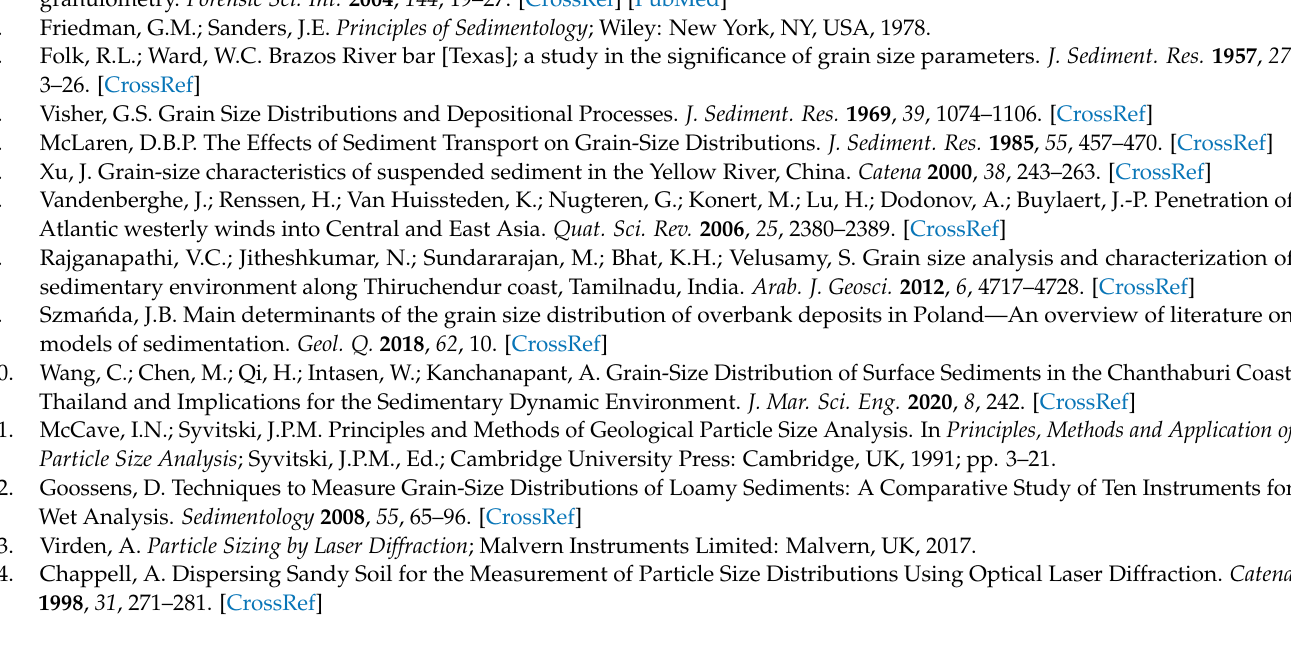
Table S5, Mean grain size and percentage of grain size fractions determined through the use of Sodium tripolyphosphate for the sediment samples of the Spitzbrunnen (SB) core, Table S6, Mean grain size and percentage of grain size fractions determined through the use of distilled water for the sediment samples of the Daschsbrunnen (DB) core, Table S7, Mean grain size and percentage of grain size fractions determined through the use of Calgon for the sediment samples of the Daschsbrunnen (DB) core, Table S8, Mean grain size and percentage of grain size fractions determined through the use of Sodium oxalate for the sediment samples of the Daschsbrunnen (DB) core, Table S9, Mean grain size and percentage of grain size fractions determined through the use of Sodium pyrophosphate for the sediment samples of the Daschsbrunnen (DB) core, Table S10, Mean grain size and percentage of grain size fractions determined through the use of Sodium tripolyphosphate for the sediment samples of the Daschsbrunnen (DB) core, Table S11, Mean grain size and percentage of grain size fractions determined through the use of different chemical dispersing agents for IL 1A and IL 1B sediment samples, Table S12, Mean grain size and percentage of grain size fractions determined through the use of different chemical dispersing agents for IL 2A and IL 2B sediment